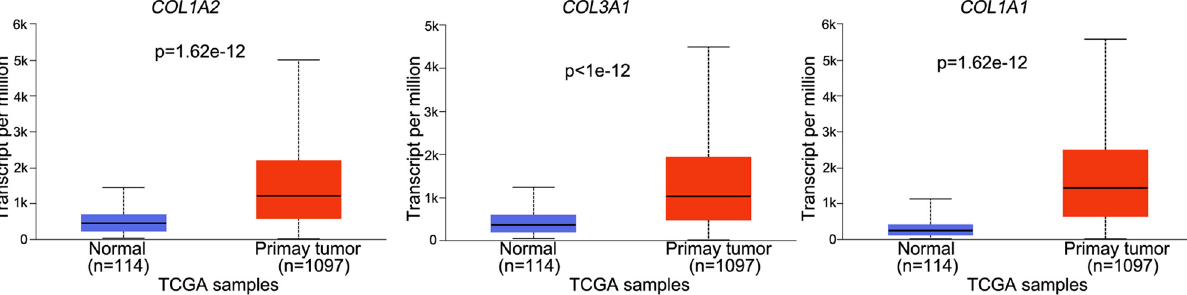
Figure 5: The expression of the COL1A1 , COL3A1 , and COL1A2 genes in the TCGA breast cancer tumor and normal control samples. The statistical di ff erences were analyzed using the UALCAN online tool. Data was expressed as median and range ( minimum to maximum )